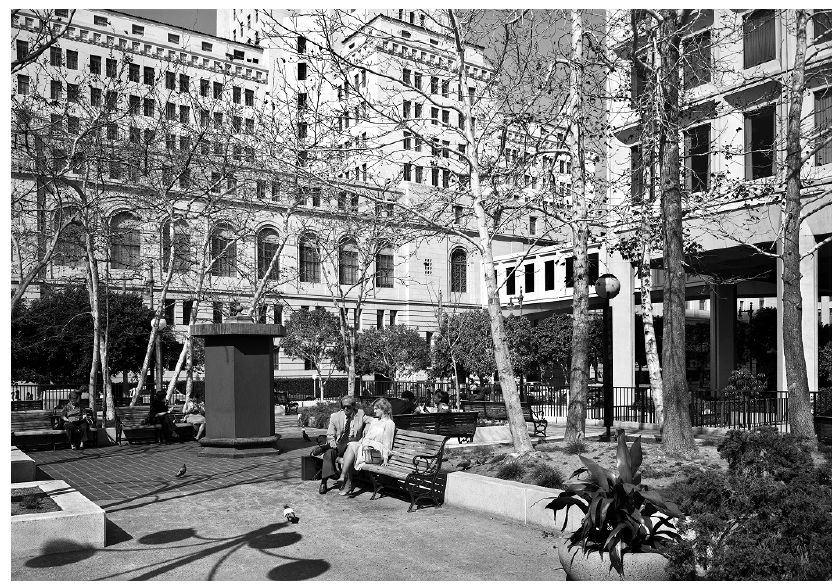
Figure 23. Anthony Hernandez Public Use Areas # 27 (1980), © Anthony Hernandez.